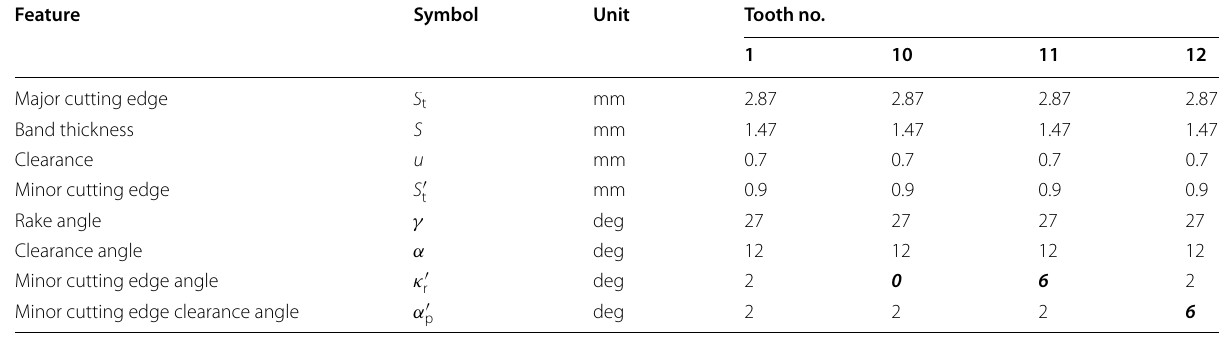
Table 3 Overview of cutting tooth geometries of series 2 where the minor cutting edge angle and minor cutting edge clearance angle are changed Feature